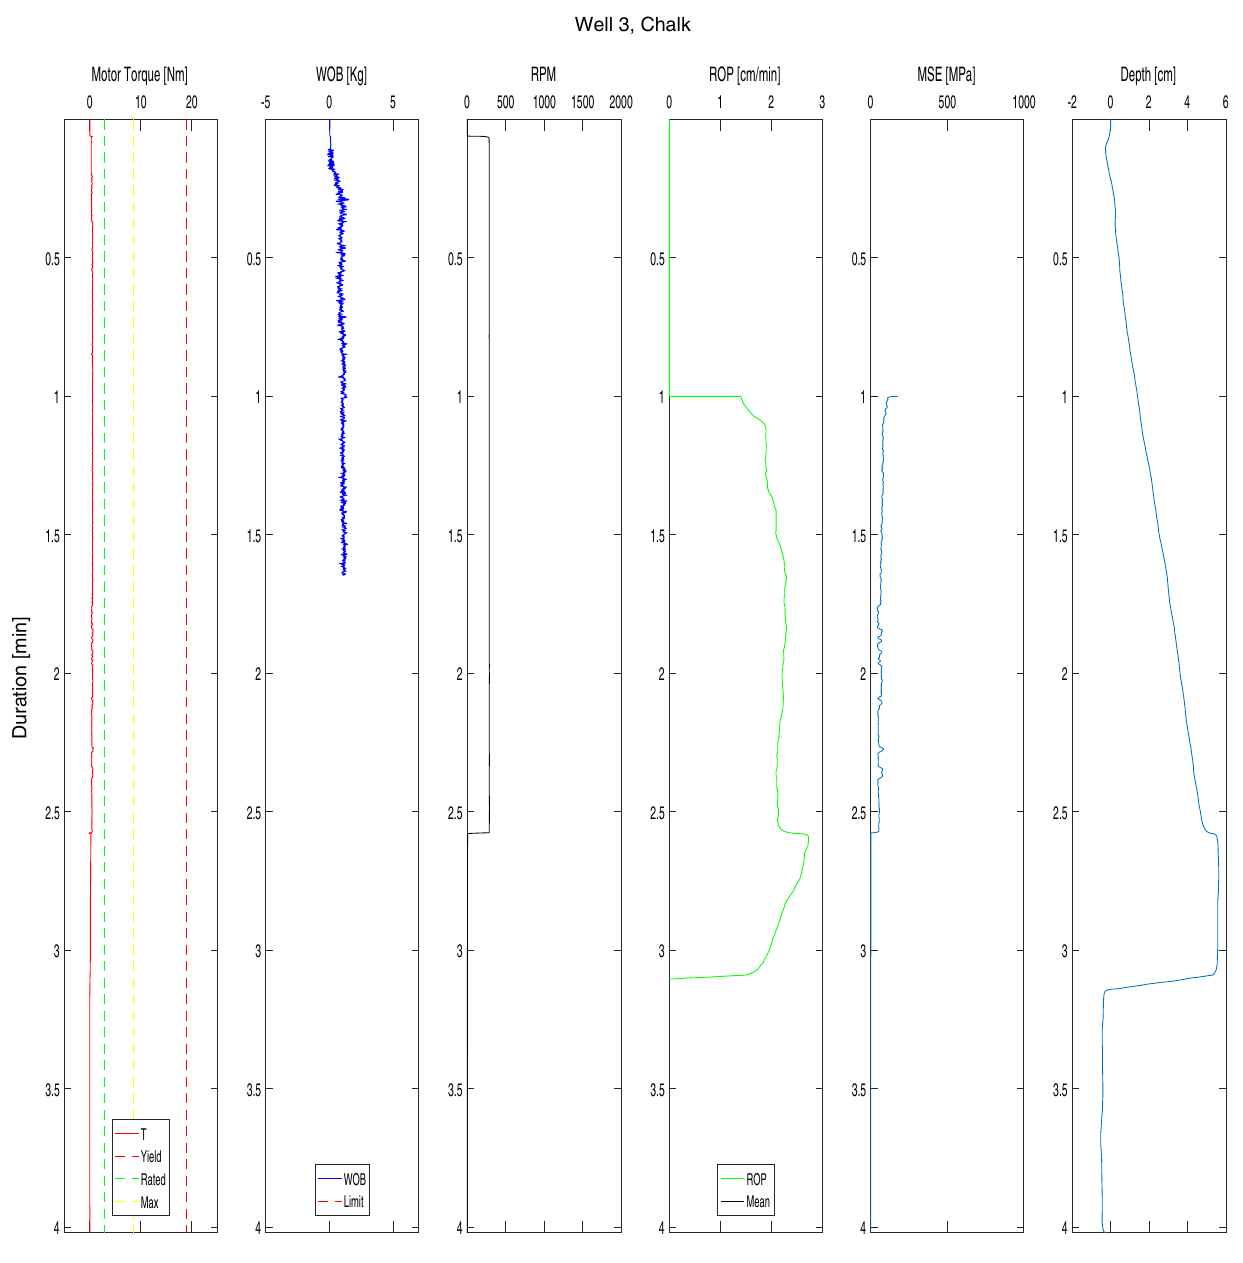
Fig. 7 Well Chalk 3, manual mode with varying